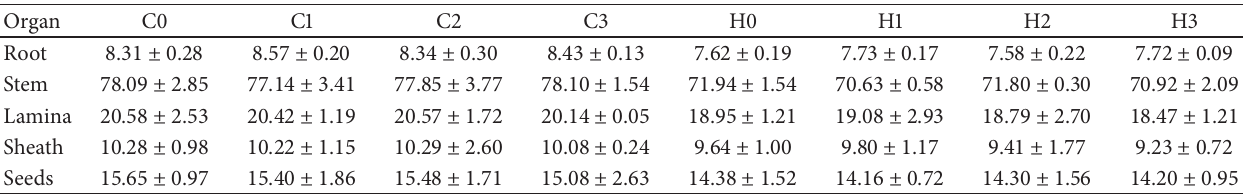
Table 3: The biomass weight of different maize organs grown with different treatments (dry mass weight, g). Root dry weight is only collected in the plough layer soil, the stem weight includes the above ground stem and the underground stem. All values are mean ± SD ( 𝑛 = 3 ).